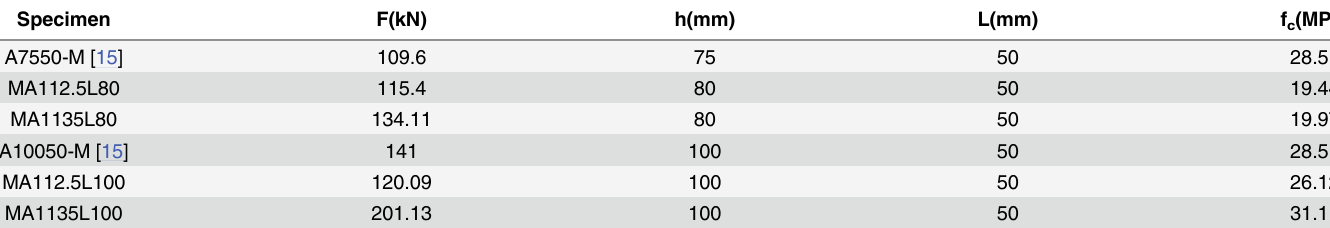
Table 5. Comparison between tilted and non tilted angle shear